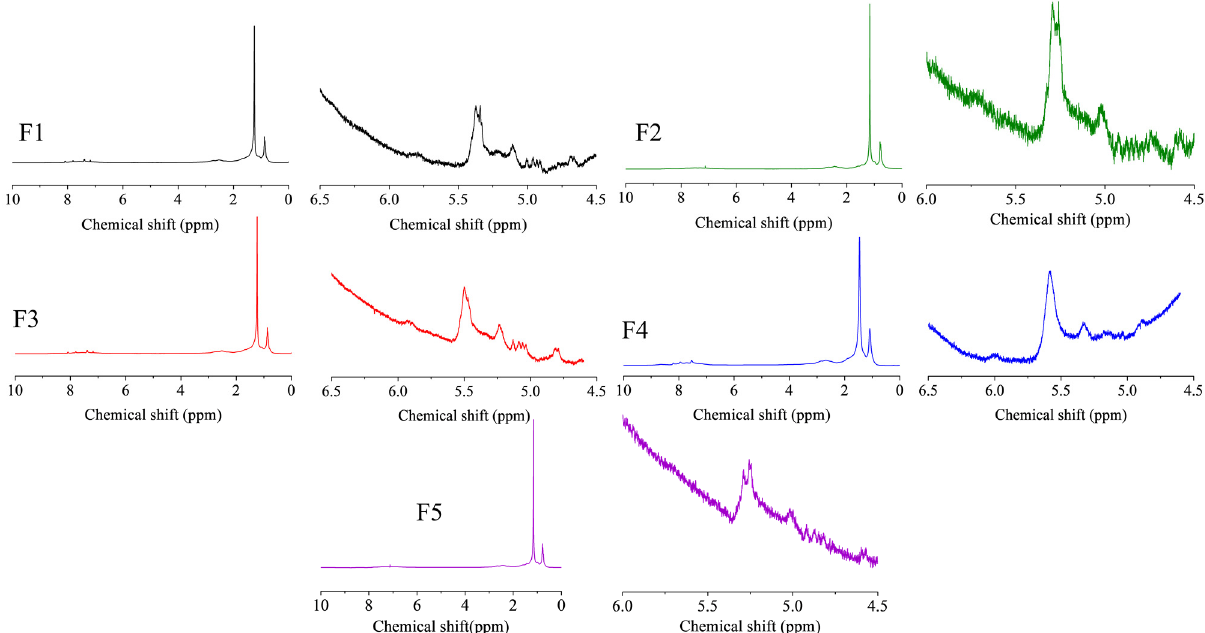
Figure 9. The 1 H-NMR spectra of FCC slurry oil before and after hydrotreatment. The feed FCC slurry oil is designated as F1; FCC after reaction with non-catalyst is designated as F2. FCC after reaction with A-MoS 2 is designated as F3; FCC after reaction with M-MoS 2 is designated as F4; FCC after reaction with Mo 2 C is designated as F5. Table 3. Hydrogen type distribution in the 1 H-NMR spectra of FCC slurry oil before and after hydrotreatment. Chemical